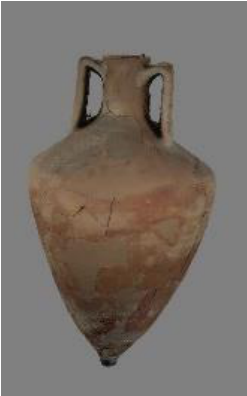
Figure 4. 3D model of the amphora from Kos